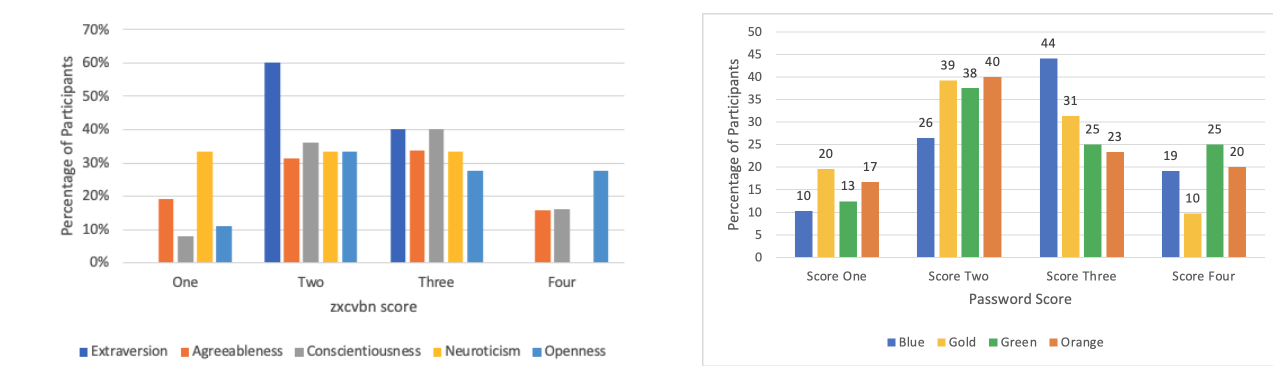
Figure 3. SONA survey: zxcvbn password scores for each Big Five personality trait.